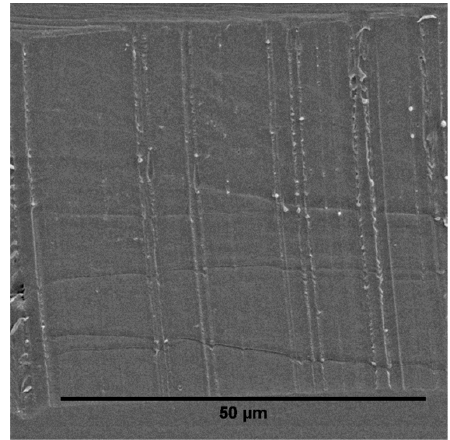
Figure 5. Cryo-sliced surface of pure PLA.